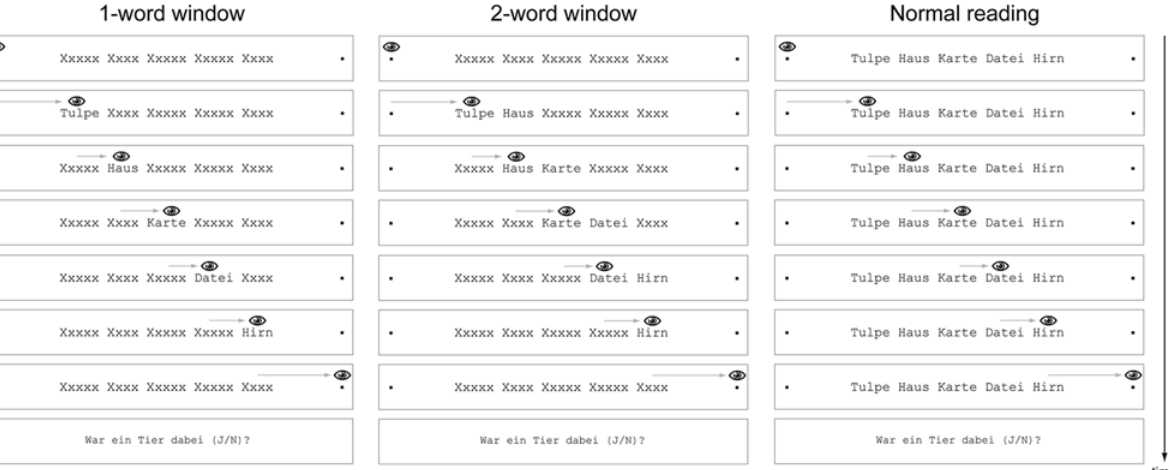
Fig 2. Trial scheme for the list reading task. Participants read short lists of German nouns from left to right with eye movements. Depicted is an example trial in the three preview conditions: 1-word moving window (left), 2-word moving window (middle), and normal reading